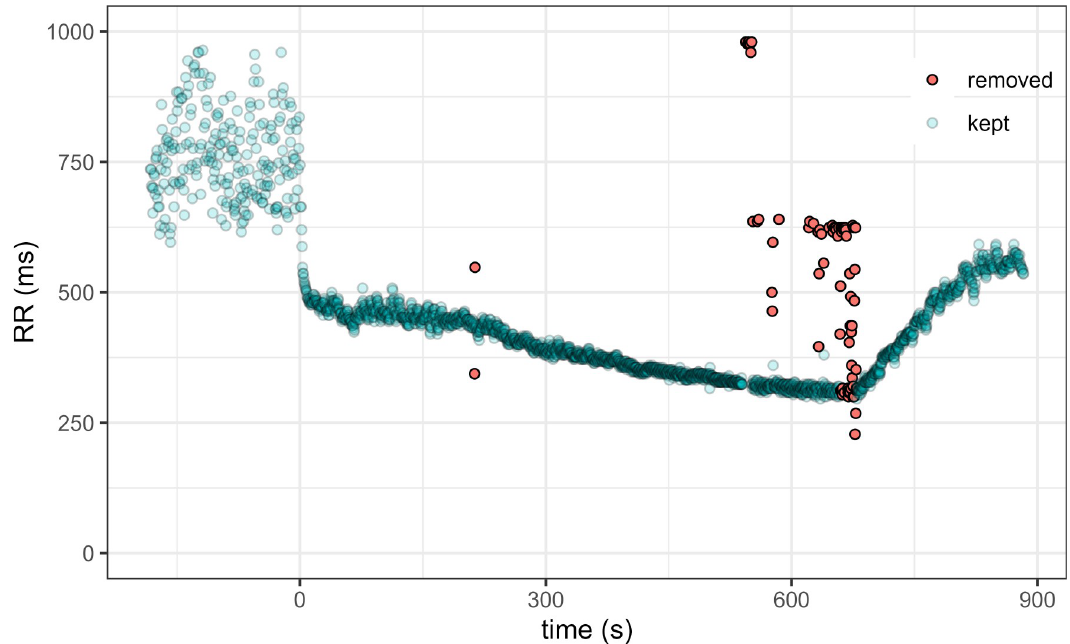
Fig 1. Example of RR series cleaning. Measured RR interval during a maximal graded effort test (effort starts at time = 0). The points removed by our cleaning procedure are indicated in red.